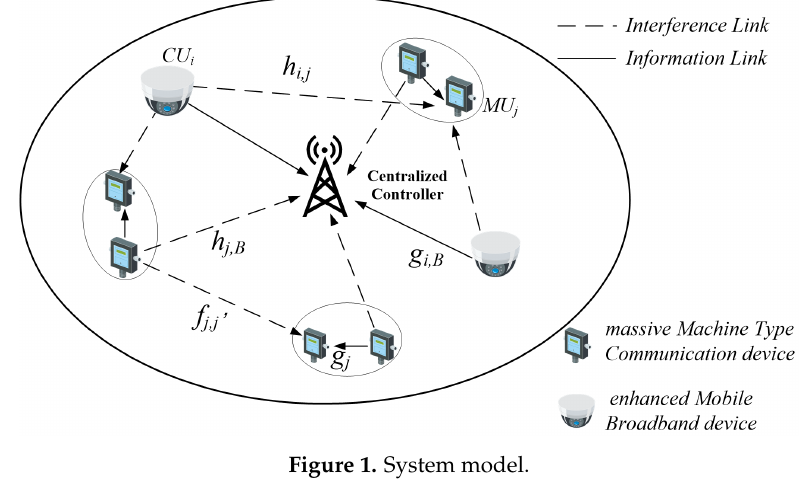
Figure 1. System model. Table 1. System